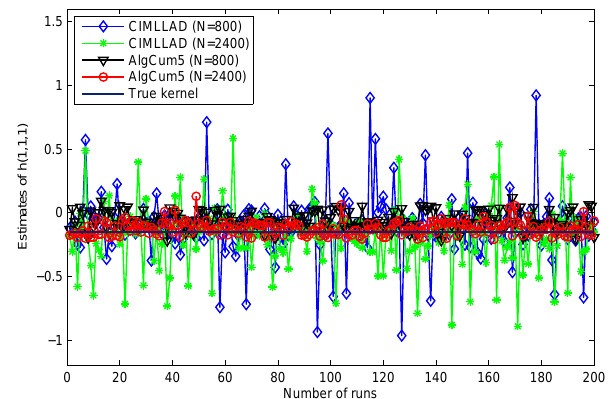
Figure 2. Estimated cubic kernel, h ( 1,1,1 ) = − 0.15, for system